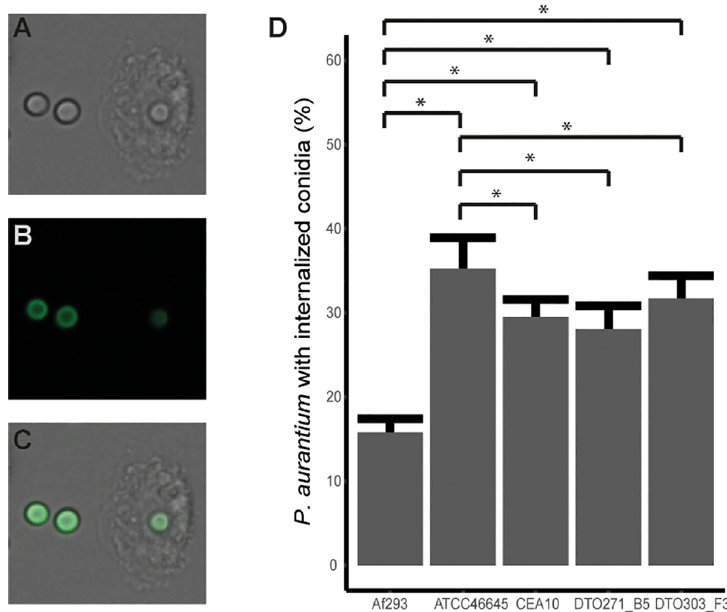
Fig 6. Uptake of swollen conidia by P . aurantium after 2 h of incubation. DIC (A) and FITC (B) channel of phagocytosed and non-phagocytosed pre-incubated conidia (4.5 h) and their merge (C). FITC signal of the phagocytosed conidia is lower due to the acidification of the phagolysosome. D) Percentage ( ± SE) of amoeba that had phagocytosed one or more conidia. Bars represent three individual experiments. � indicates statistical significance, based on a Kruskal Wallis test with a p-value � 0.05.